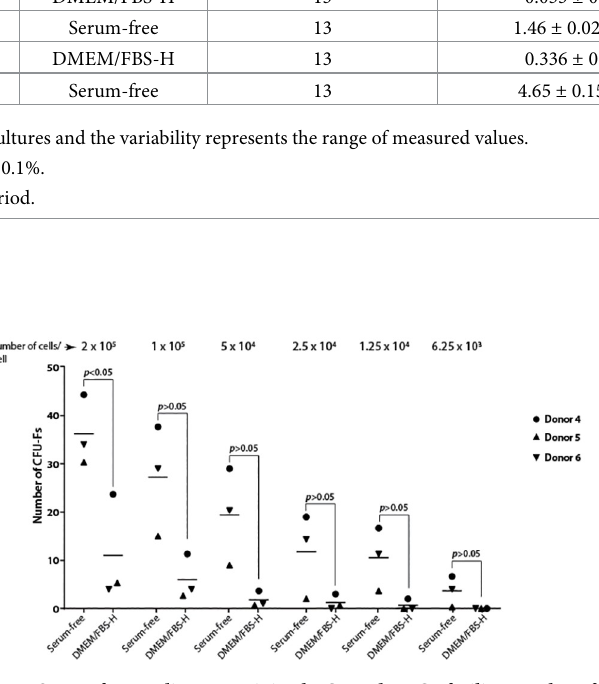
Fig 8. Serum-free medium containing bFGF and PDGF facilitates colony formation by canine Ad-MSCs. Freshly isolated canine Ad-MSCs from 3 additional donors (donors 4–6) were placed directly into serum-free medium containing bFGF and PDGF in parallel with DMEM/FBS-H in serial dilutions indicated on the top of the figure. CFU-Fs were enumerated 21 days later. Means of three replicates for each donor are